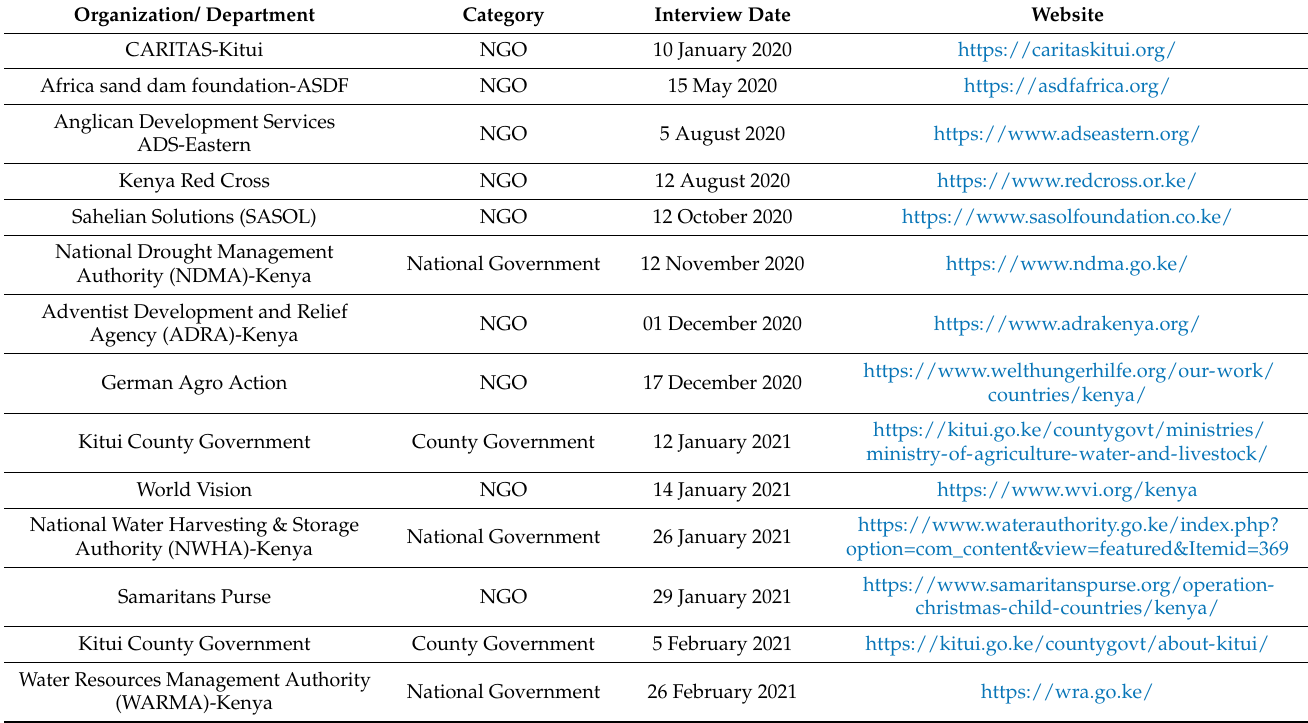
Table 2. Key informants with operations in Kitui West and their corresponding designation, categorization, organization, or department and interview